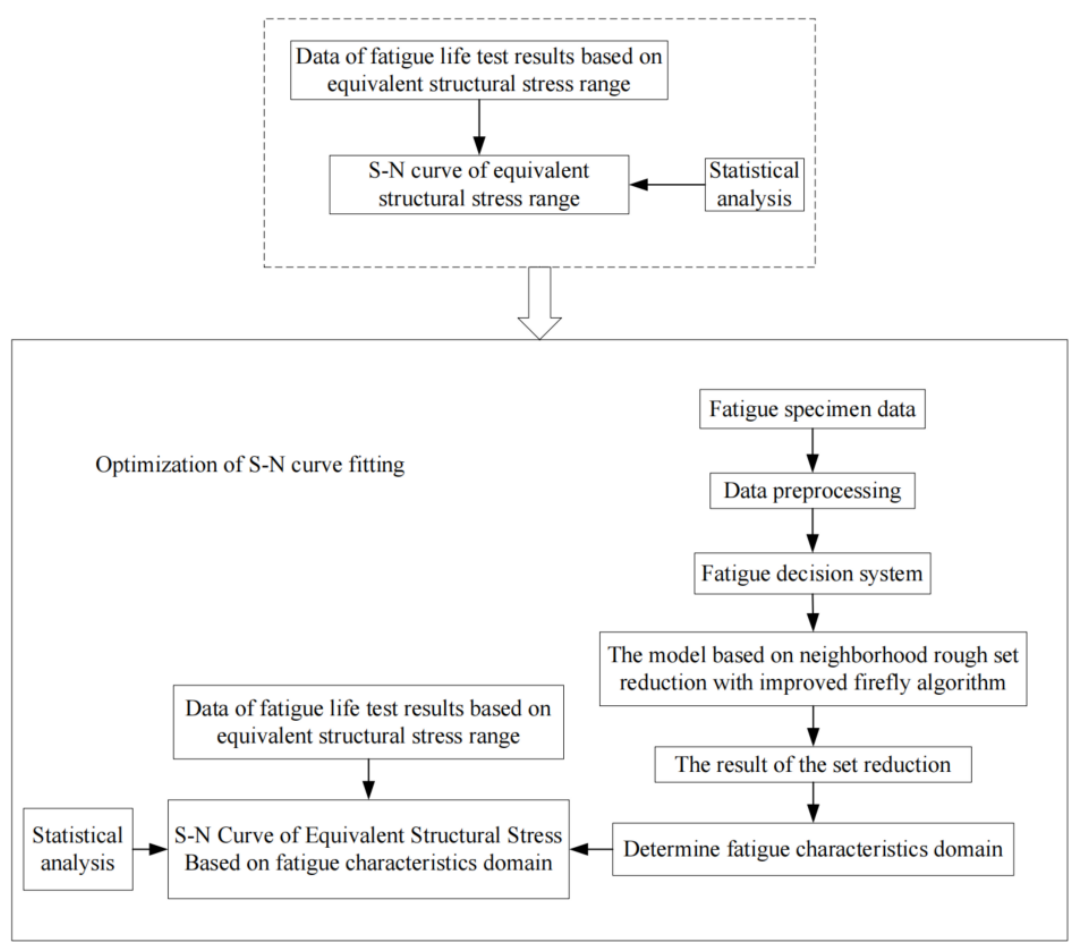
Figure 2: optimization of S-N curve